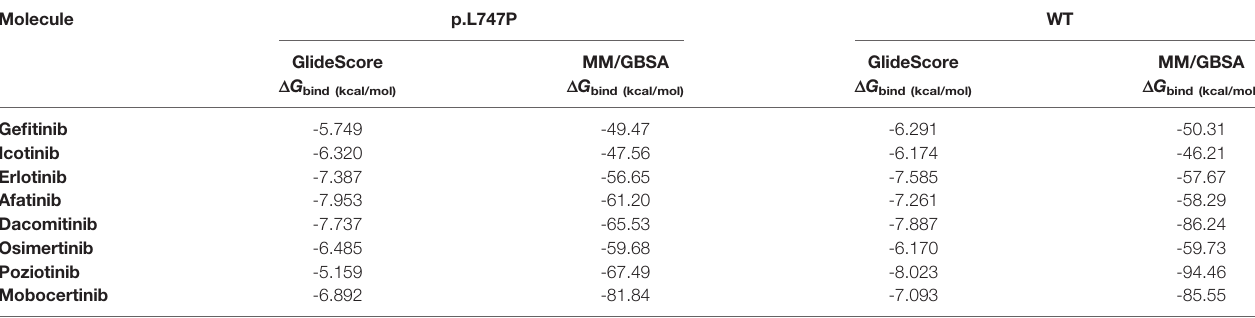
TABLE 2 | Binding free energies with different EGFR TKIs for p.L747P and WT of EGFR by dynamics calculation.